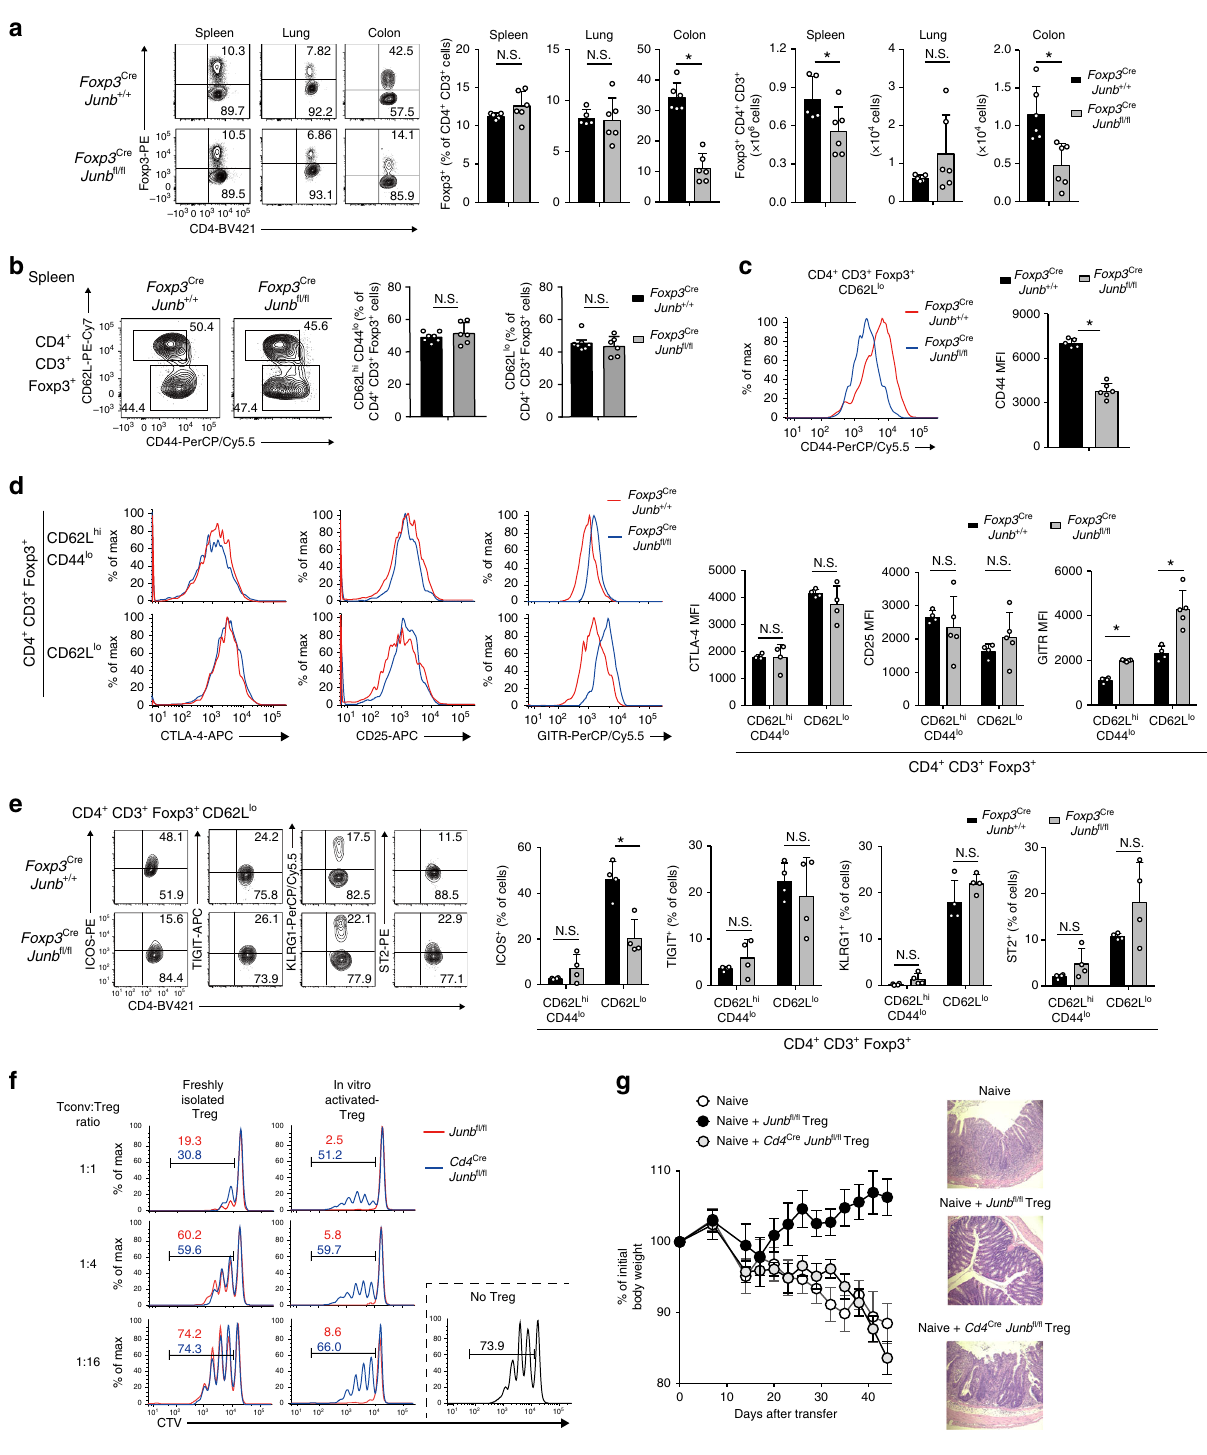
mice (Fig. 4b). As in diseased Foxp3 Cre Junb fl / fl mice, MFIs of CD44 expression in CD62L lo eTreg cells of Cd4 Cre Junb fl / fl mice were signi fi cantly lower than in Junb fl / fl mice (Fig. 4c).